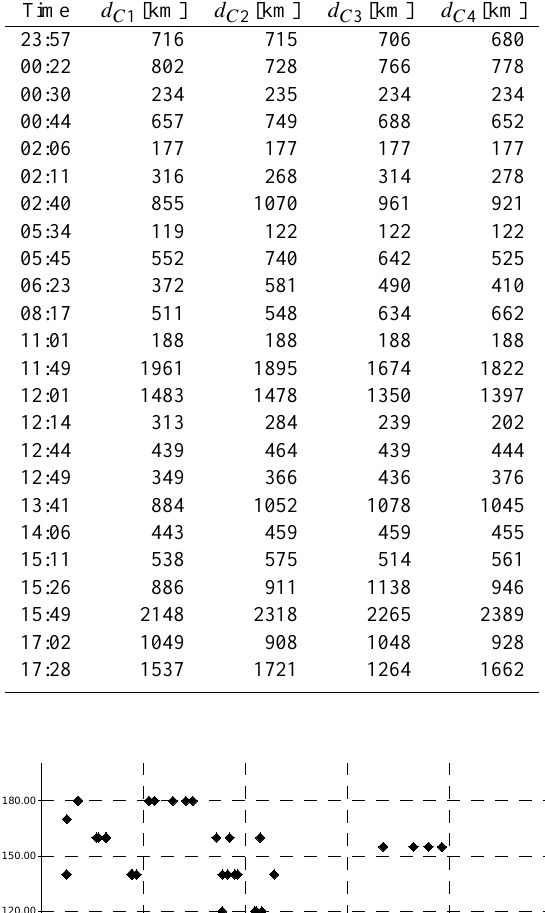
Fig. 10. Histograms of magnetopause (MP) speed, thickness and current density for 24 dawn flank magnetopause crossings by all 4 spacecraft on 4/5 July 2001, resulting in a total of 96 individual crossings. Note that the bins are logarithmically spaced.